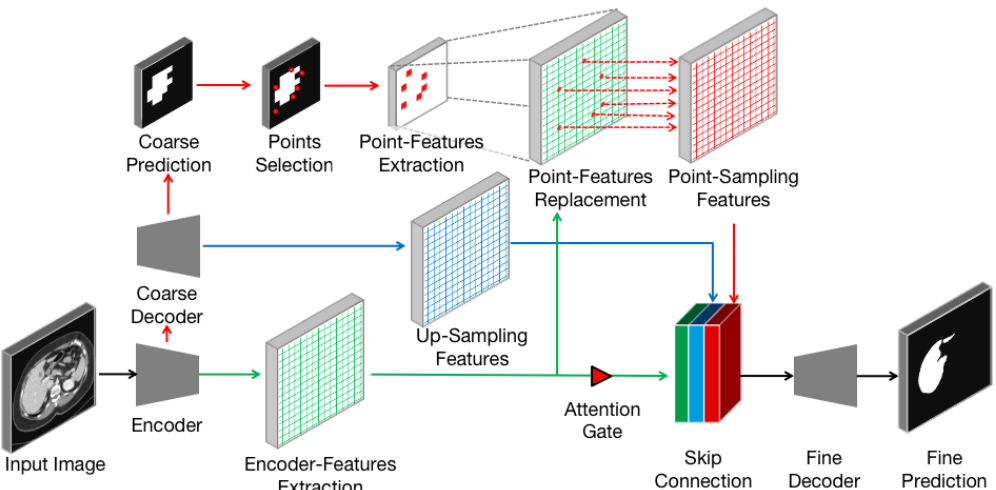
Figure 4. Detailed analysis of the point-sampling method was applied to image semantic segmentation. A set of uncertain points from coarse prediction was selected to extract point-features. These features will replace original upsampling features and concatenate to refine the